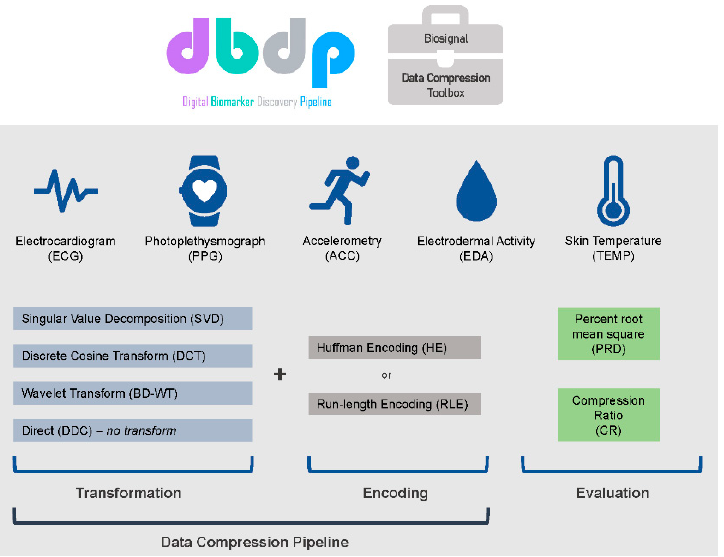
Figure 1. Graphical Abstract for the Biosignal Data Compression Toolbox